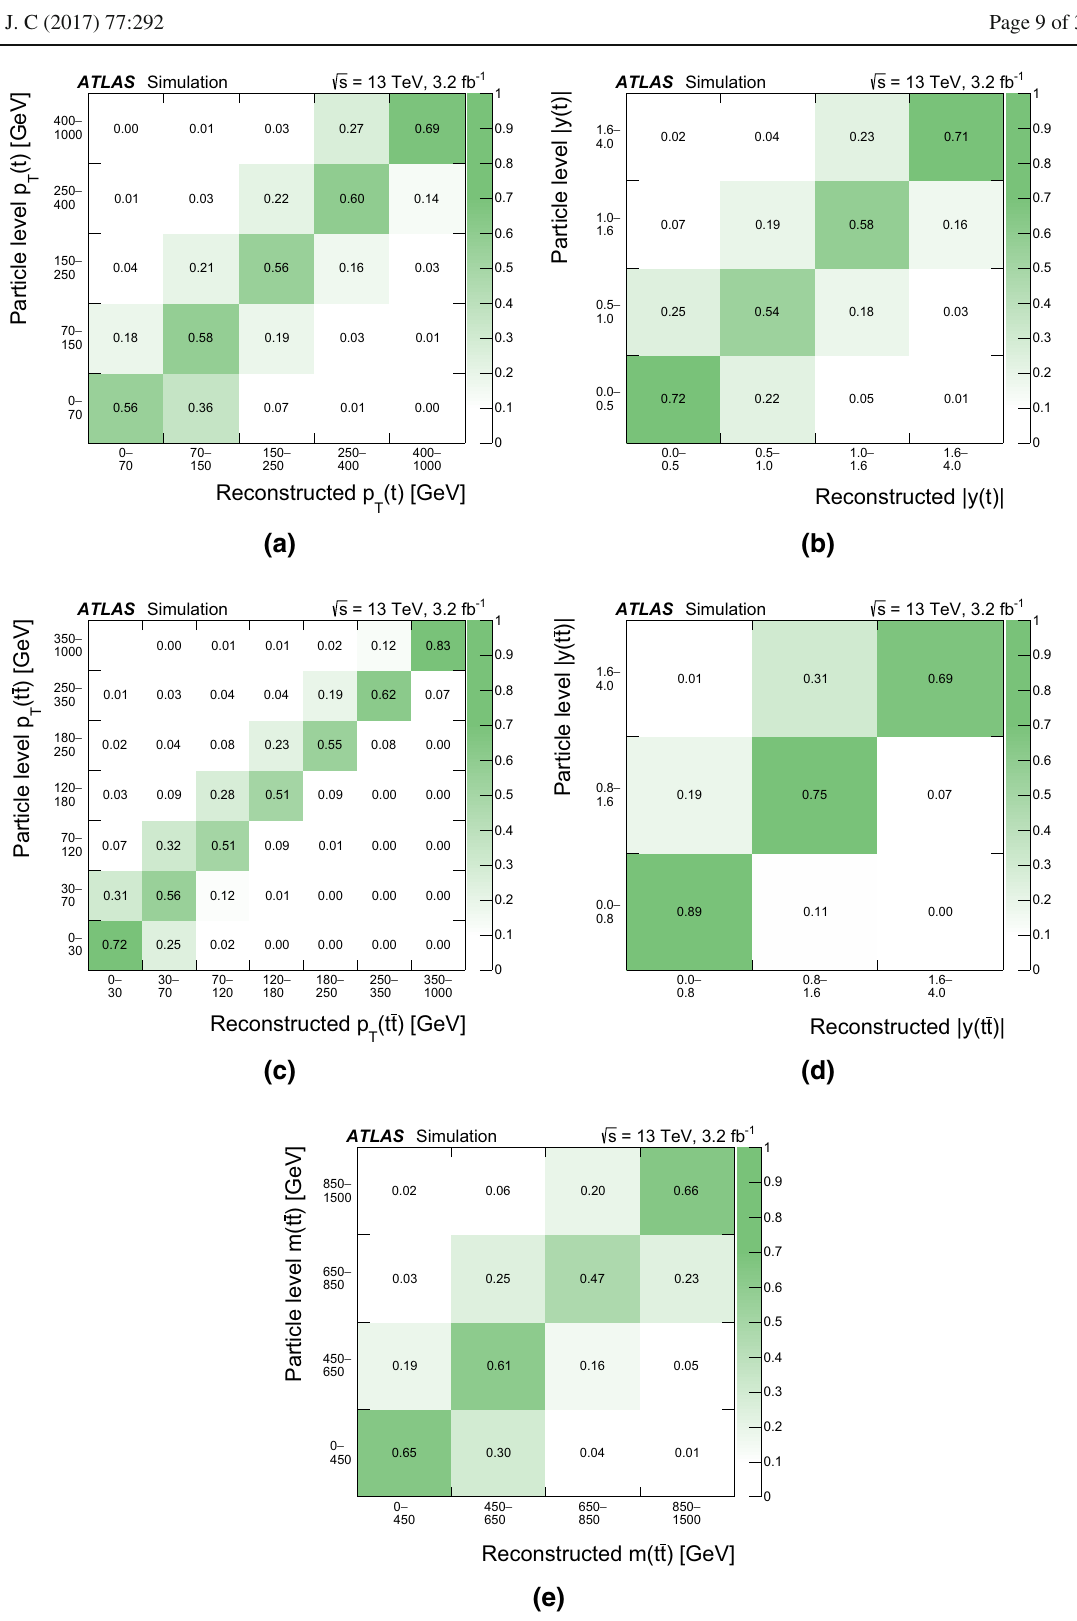
level bin i . White corresponds to 0 probability and the darkest green to a probability of one, where the other probabilities lie in between those